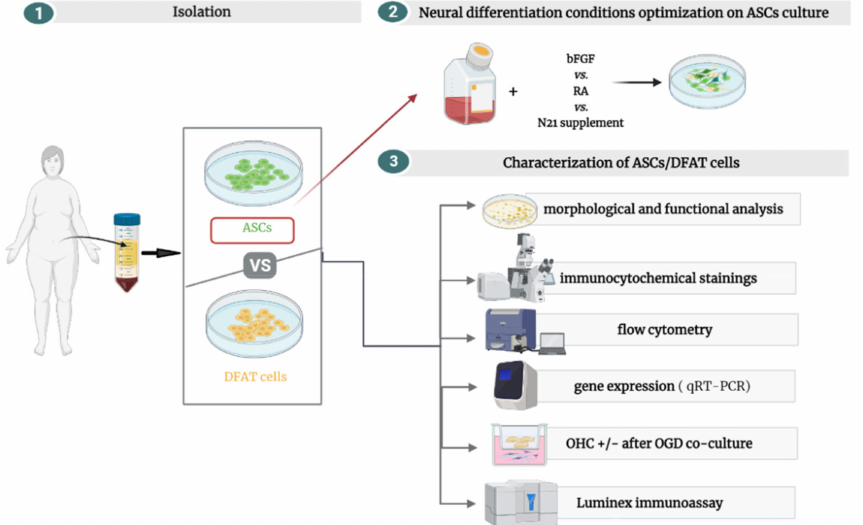
Figure 2. General overview of our study experimental steps. After isolation, ASCs were used to optimize the best conditions for neural differentiation, which were applied in further investigation of ASCs/DFAT cells’ proliferative, neurogenic, and neuroprotective potential. The figure was created in BioRender (https://biorender.com/, accessed date: 10 January